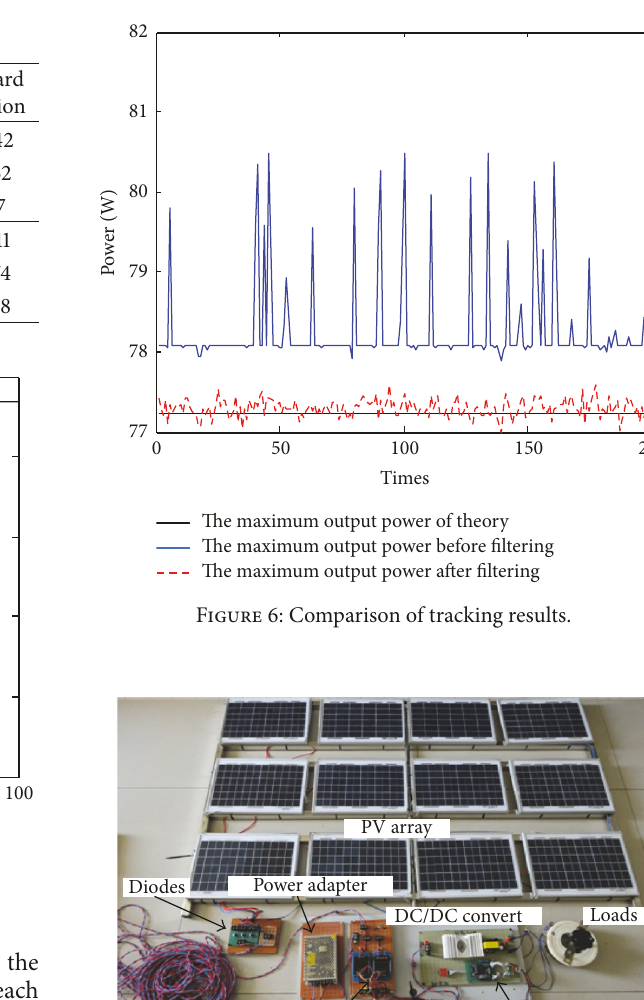
Figure 7: Experimental